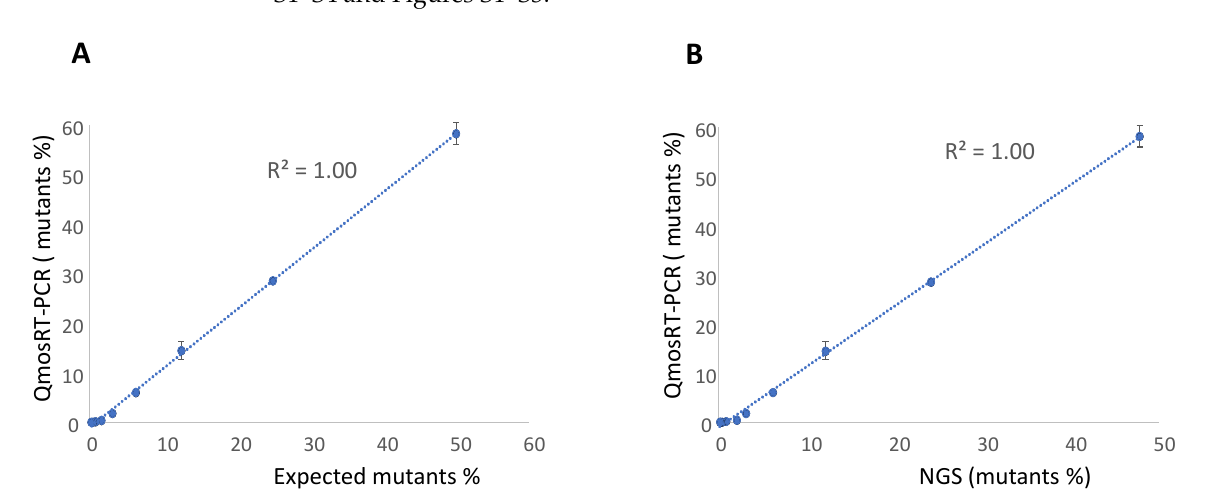
Figure 2. Results of the qmosRT-PCR assay using plasmid references for quantification of nOPV2- c1_171 mutants generated from the plasmid-spiked samples (mutant plasmid spiked in non-mutant plasmid): ( A ) Expected mutant percentages versus percentages generated by qmosRT-PCR and ( B ) mutant percentages generated by NGS versus those generated by qmosRT-PCR. The correlation line is drawn for the averages of the qmosRT-PCR results. Table 3. Quantification of nOPV2-c1_171 mutants in the virus-spiked samples by qmosRT-PCR assay using plasmids as reference